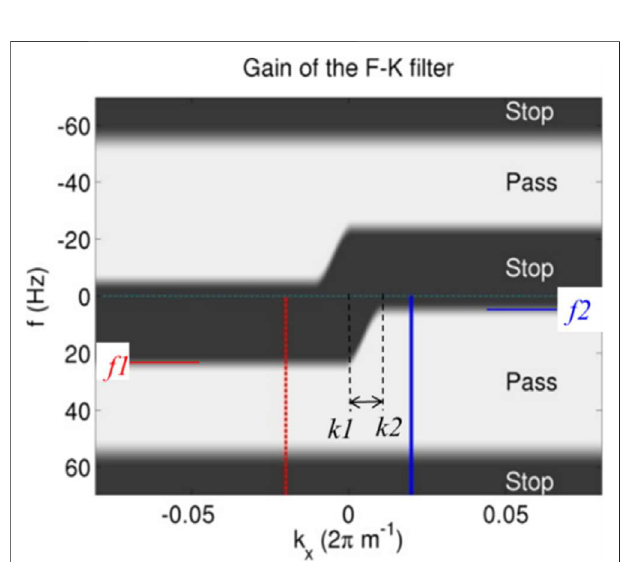
FIGURE 2 | A representative common-shot gather of surface seismic data. Red rectangles enclose the ground-roll noise. The cyan rectangle encloses re fl ection signals. The vertical red dashed line and blue solid line stride across the ground-roll noise and re fl ection signals, respectively. The single-barbed arrows indicate the wavenumber directions.